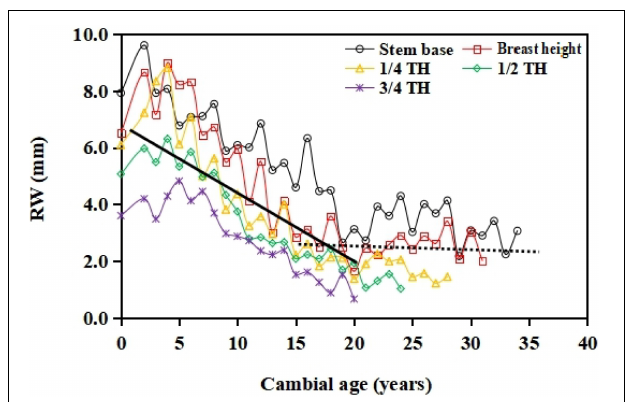
FIGURE 3 | Within-tree trends in ring width (RW) during the self-thinning of S. tzumu stands. The different curves correspond to different stem heights. The crossing point between the black straight solid line and the dotted line shows the transition from juvenile and mature wood at the cambial age from the pith to the